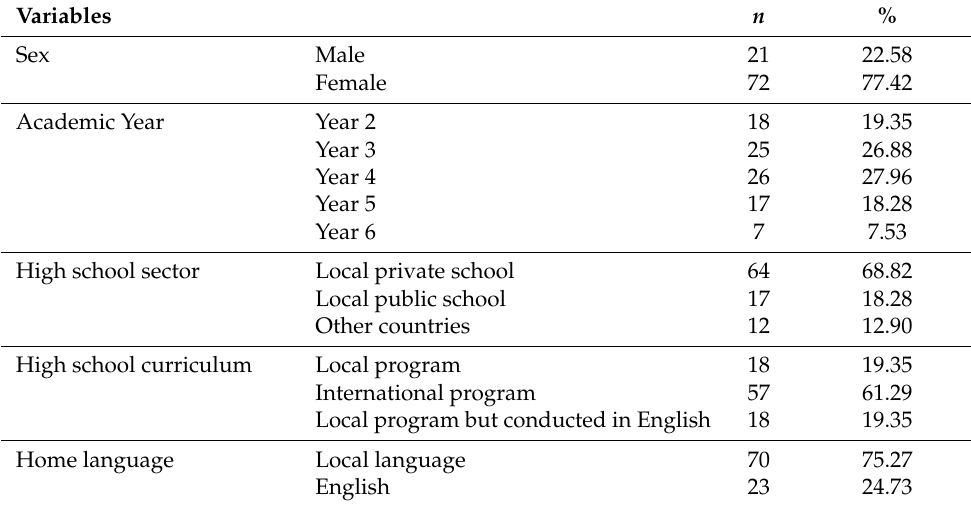
Table 1. Demographics of research participants.